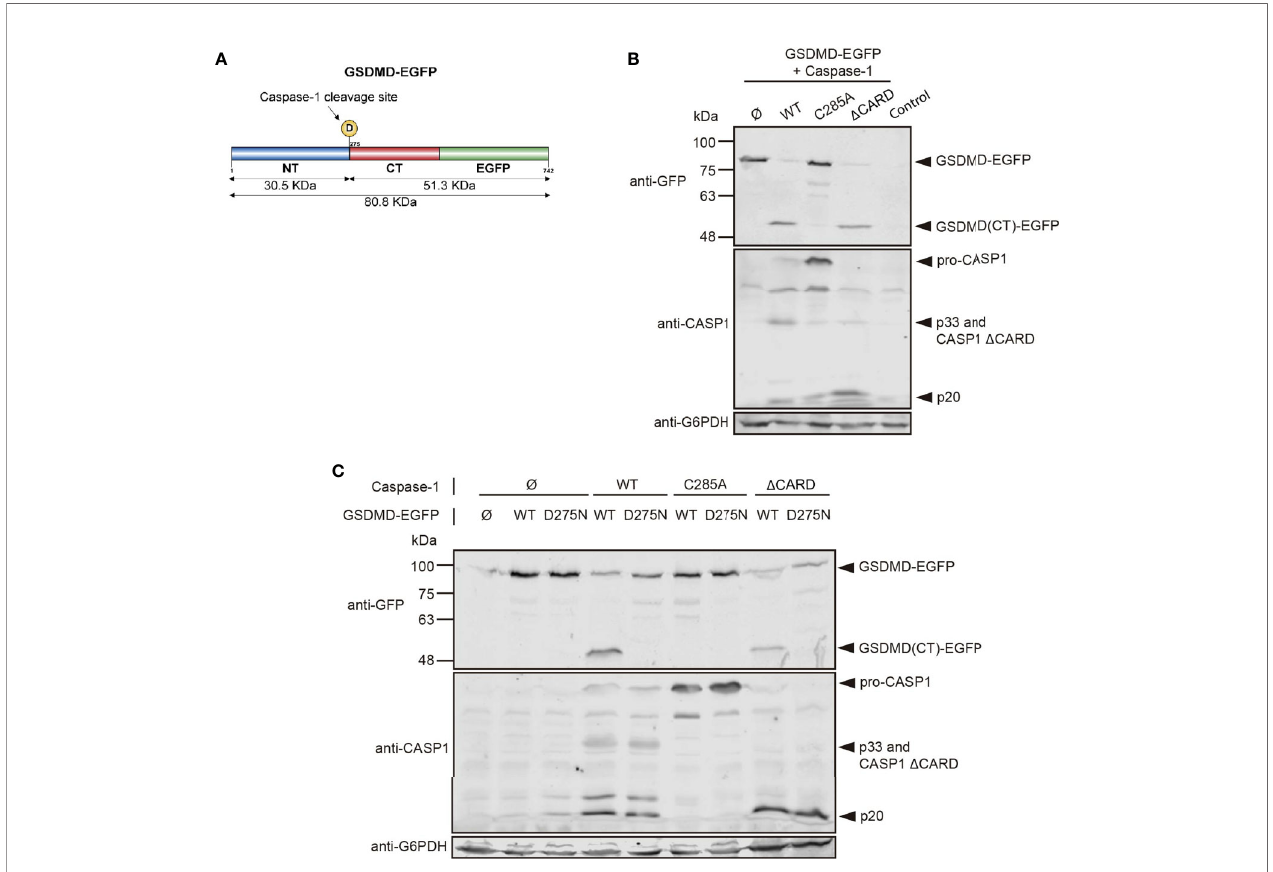
FIGURE 9 | Caspase-1 cleaves its substrate GSDMD in yeast. (A) Schematic representation of GSDMD depicting its N-terminal domain (NT; blue) and C-terminal domain (CT; red), fused in C-terminal to EGFP (green). The D275 residue susceptible of caspase-1 cleavage and the molecular weight of the cleavage products are indicated. (B) Immunoblot showing GSDMD-EGFP processing in yeast lysates of cells bearing pAG416-GSDMD-EGFP and pAG413-caspase-1 WT, C285A, or D CARD, respectively, after 5 h induction in SG medium. pAG413 and pAG416-EGFP plasmids were used as controls. (C) Immunoblot showing